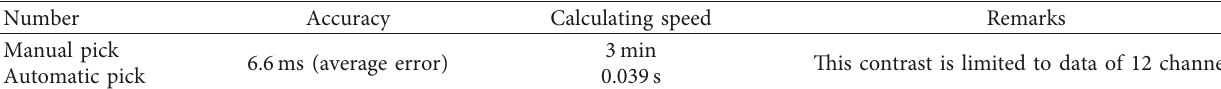
Figure 13: Envelope curve of MS event potential distribution area (calculated based on-time difference and wave velocity). Table 6: Comparison of picking methods in terms of speed and accuracy.